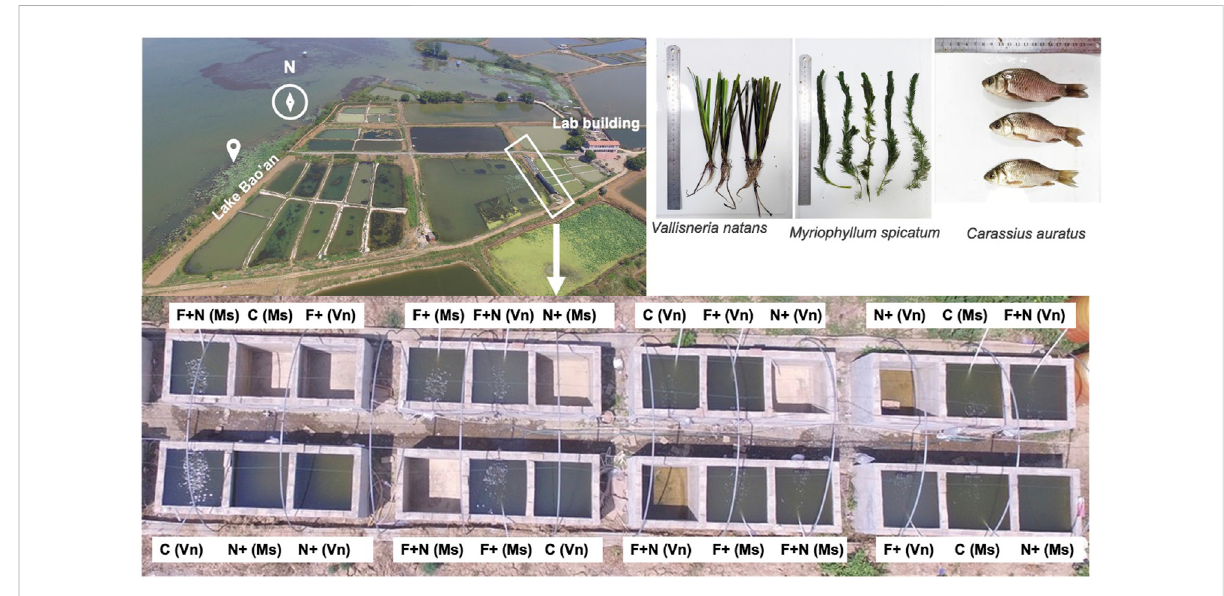
FIGURE 1 The mesocosm experimental systems. C, F+, N+, and F + N represent the following treatments: control, fi sh introduction alone, ammonium loading alone and both fi sh introduction and ammonium loading, respectively. Vn, Vallisneria natans ; Ms, Myriophyllum spicatum